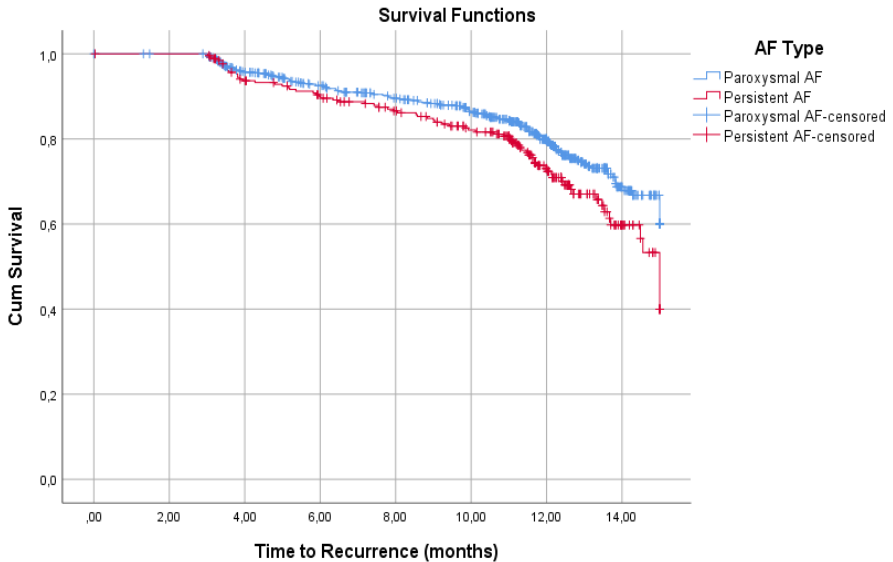
Figure 1. Recurrences Kaplan-Meier survival analyses. PaAF patients had a higher percentage of freedom from AF recurrence than PeAF patients at 15 months (78.9% vs. 70.9%, respectively). The curves show significant differences ( p = 0.015), which are more accentuated after 10 months.